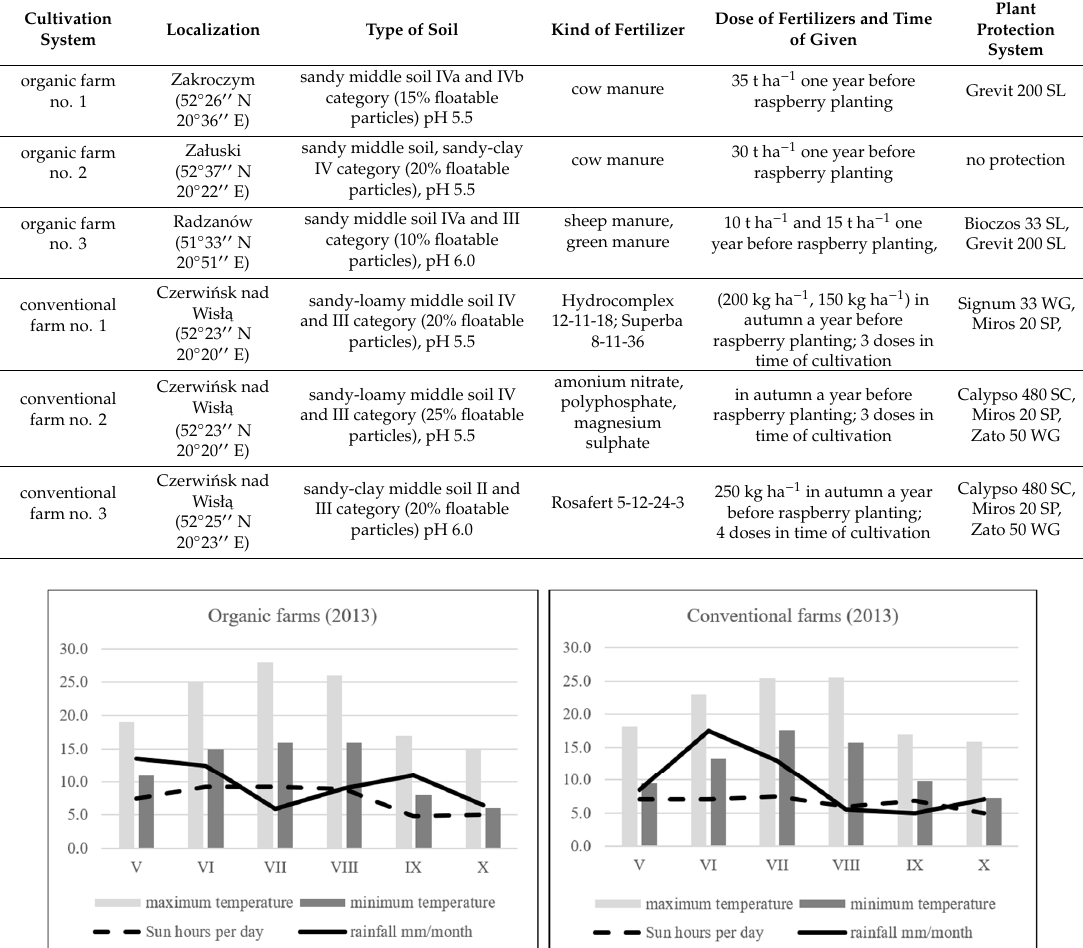
Figure 1. Weather conditions at the experimental farms (organic and conventional) in time of raspberry leaves